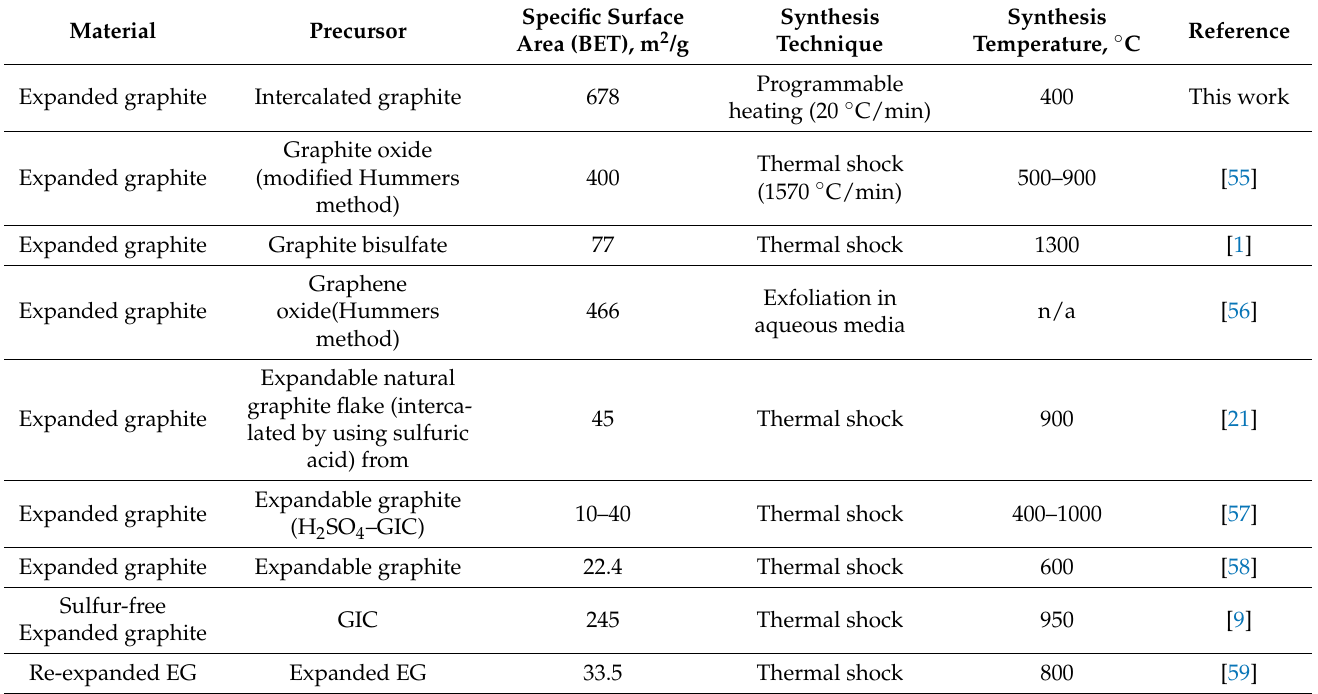
Table 6. Surface area values of expanded graphite and related materials reported in literature depending on precursor type, synthesis technique, and synthesis